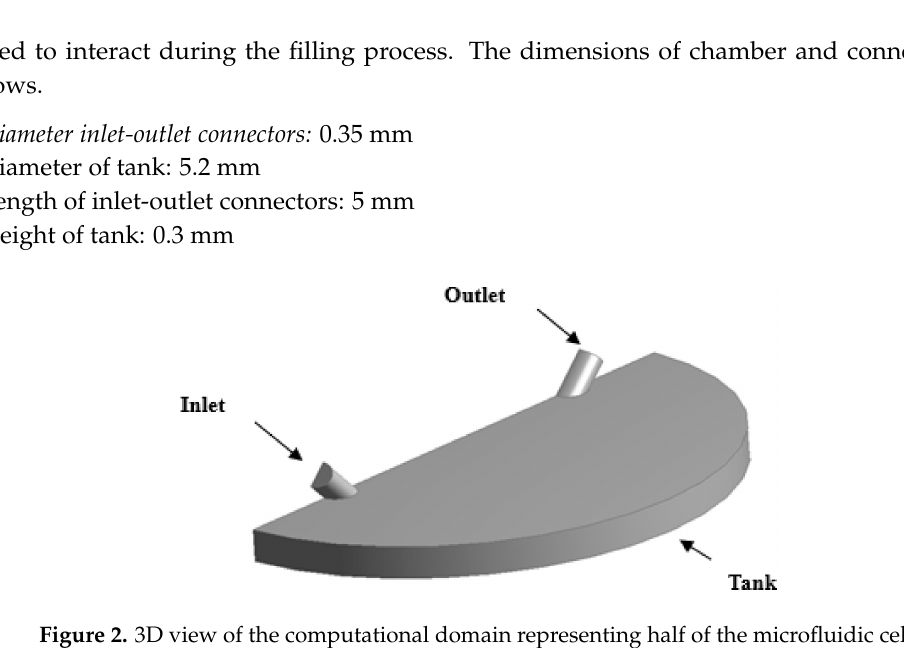
Figure 2. 3D view of the computational domain representing half of the microfluidic cell.